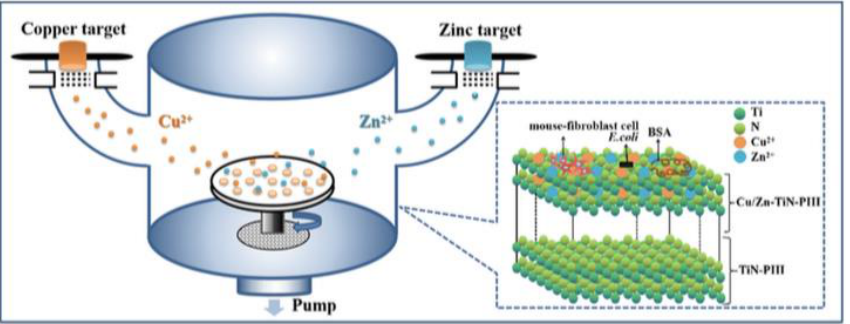
Figure 2. Schematic and structural diagrams of ion implantation. Reproduced with permission from Ref. [46]. Copyright 2019, American Vacuum Society.